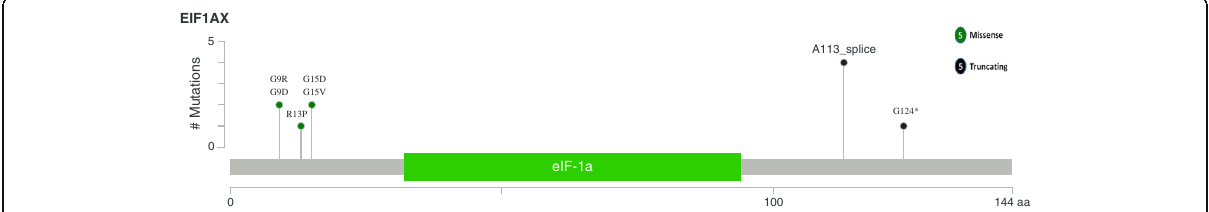
Fig. 2 EIF1AX mutations detected in our cohort. The colored box depicts the functional domain along the protein. The location of the circle specifies the mutation site. A patient is represented by a circle. Green circles represent missense mutations and black circles represent truncating mutations. The number of circles in a lollipop represents the number of patients harboring the specific